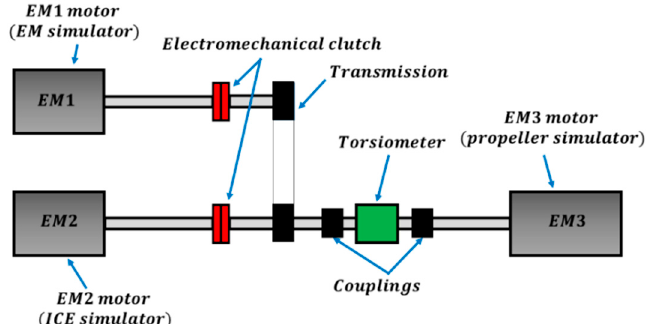
Figure 2. Functional scheme of the real test bench for the parallel hybrid propulsion architecture under analysis.